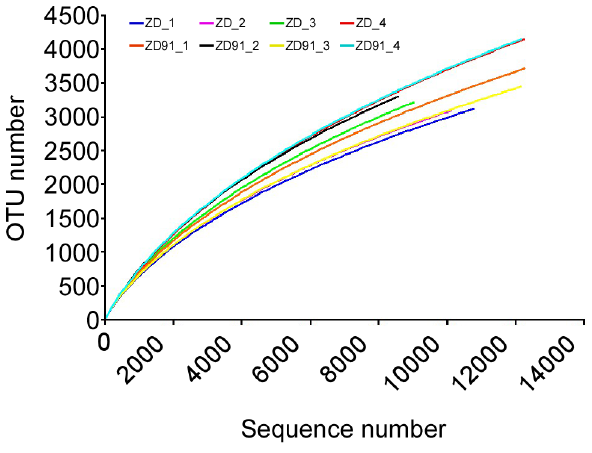
Figure 1. Rarefaction analysis. Rarefaction curves of OTUs clustered at 97% sequence identity across the samples. The sample labeled with ZD_1, ZD_2, ZD_3 and ZD_4 correspond to four replicates of cultivar ZD; ZD91_1, ZD91_2, ZD91_3 and ZD91_4 represent four replicates of transgenic cultivar ZD91.